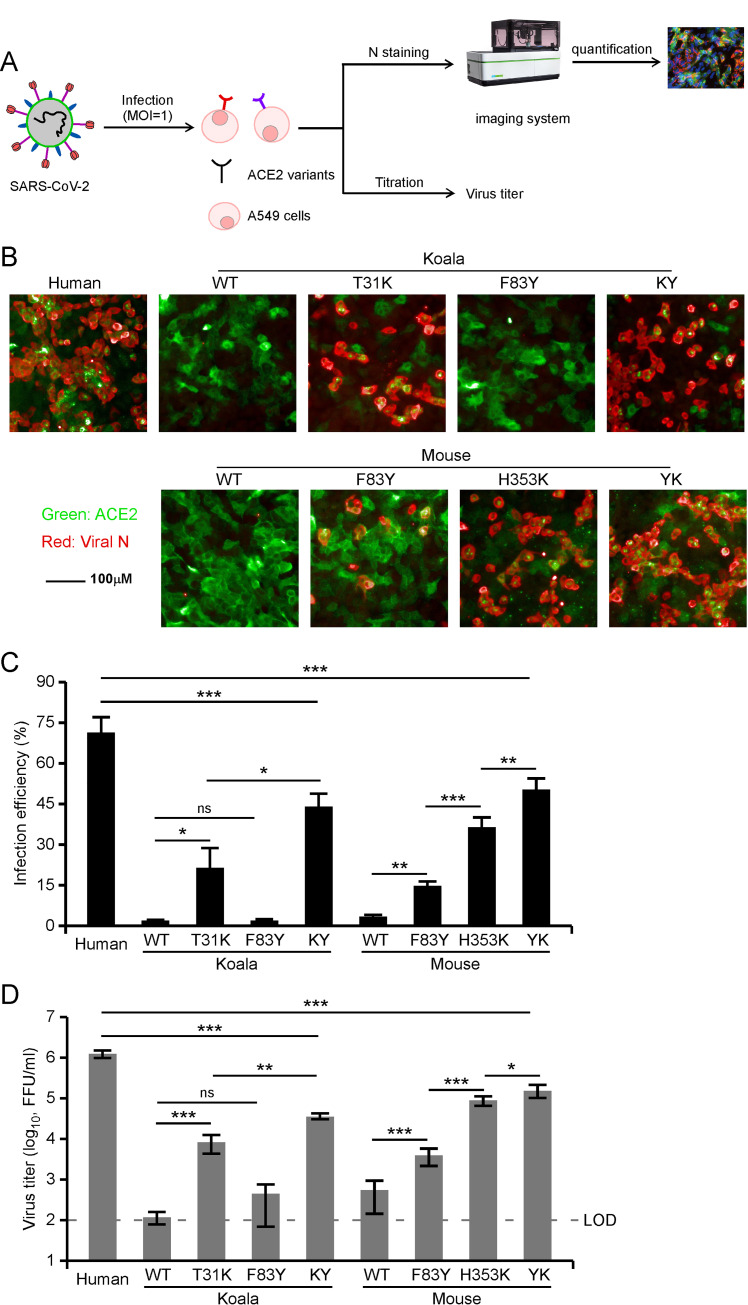
The capability of ACE2 mutants to facilitate viral entry in vitro.(A-B) A549 cells transduced with lentiviruses expressing ACE2 orthologs or humanized mutants were infected with SARS-CoV-2 virus (MOI = 1). Expression of the viral nucleocapsid protein was visualized by immunofluorescence microscopy. Viral nucleocapsid (N) (red), and ACE2 (green) are shown. (C) The infection was quantified by a high-content imaging system. (D) The cell culture medium was collected and then virus titer was determined by focus-forming assay. The graph shows the mean and SD (mean ± standard deviation) from two independent experiments performed in triplicate. ns, no significance; *, P < 0.05, **, P < 0.01, ***, P < 0.001. Significance assessed by one-way ANOVA.